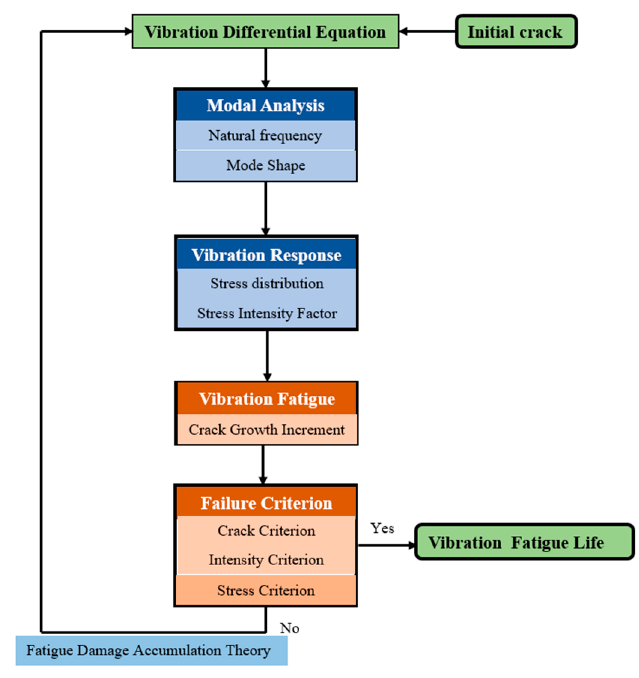
Figure 3. Flow chart of loose coupling analysis method.